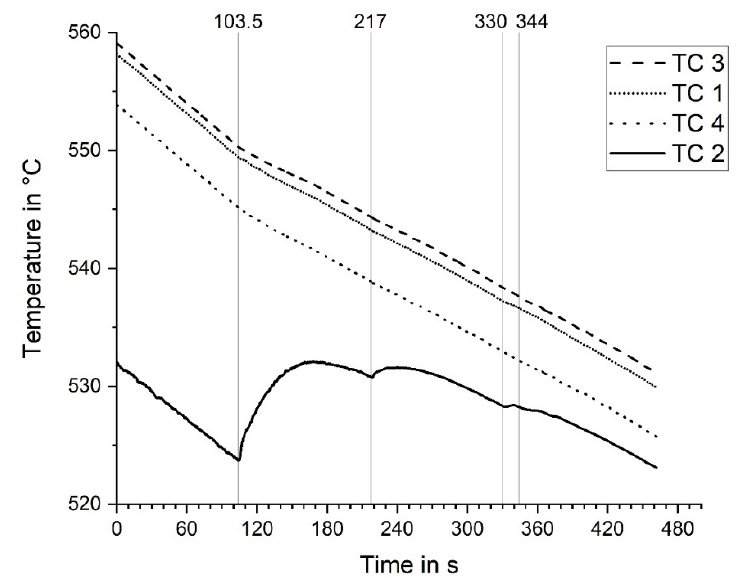
Figure 8. Effect of gas flow on TC temperature. The gas flow velocity decreases at the highlighted times.